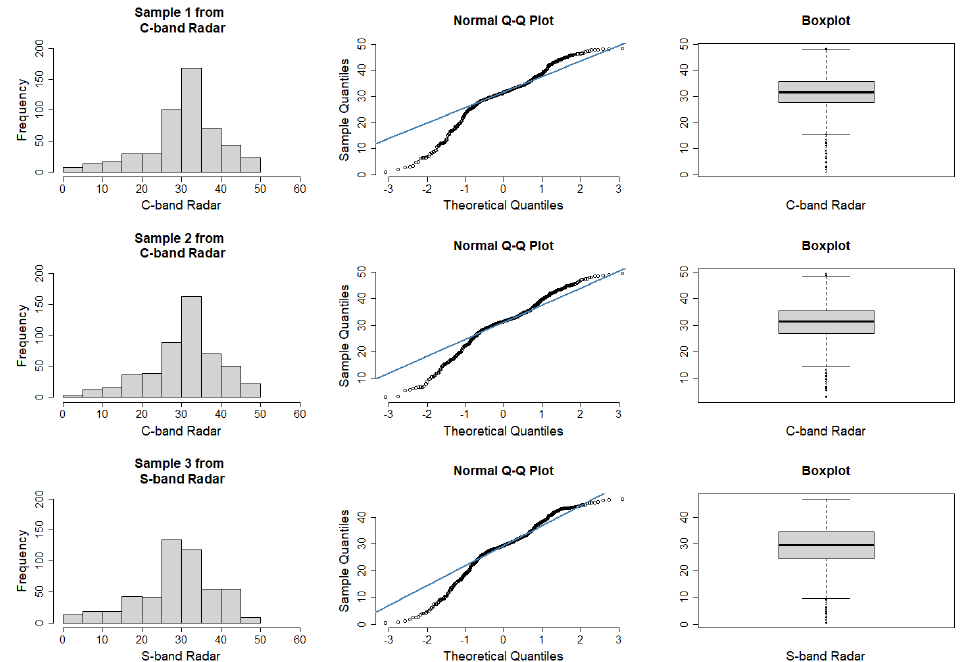
Figure 1. Radar reflectivity data: histograms, normal QQ-plots and boxplots. Sample 1 and sample 2 were taken from the C-band radar population with each sample size n = 500. Sample 3 was taken from the S-band Radar population with the same sample size n = 500.